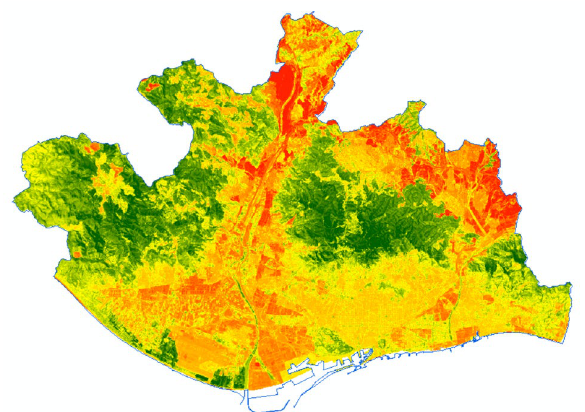
Figure 10. Daytime LST (segmented model)